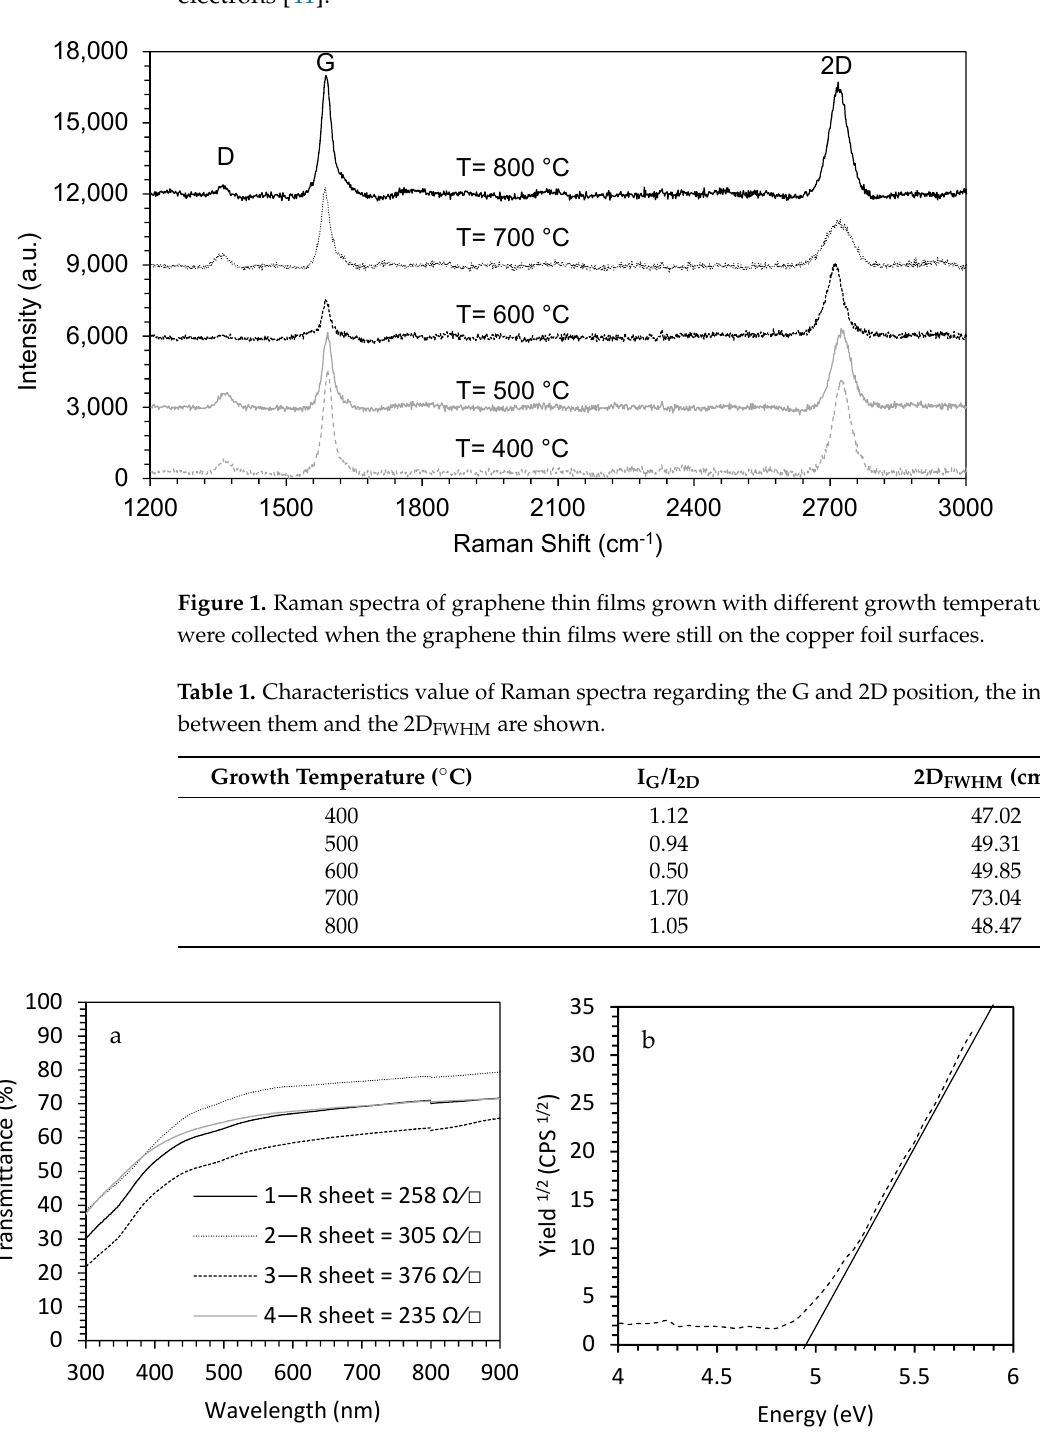
Figure 2. ( a ) Representative UV-Vis light transmission spectra for graphene thin films with sheet resistance ( Ω / □ ). ( b ) Work function of graphene film transferred onto ITO-glass substrate.